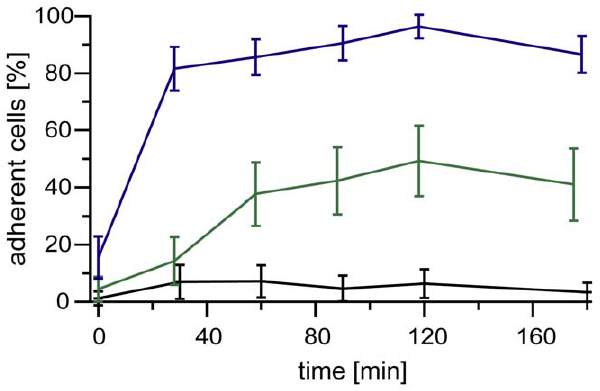
Figure 2. The impact of the average distance between oligo-HA molecules on adhesion of 1AS cells. The fraction of 1AS cells adhered to the indicated supported membranes plotted as function of time. The three membranes studied were pure DOPC membranes (black line), and membranes displaying oligo-HA at , d . , 11 nm (green line) and , d . , 5.5 nm (blue line).